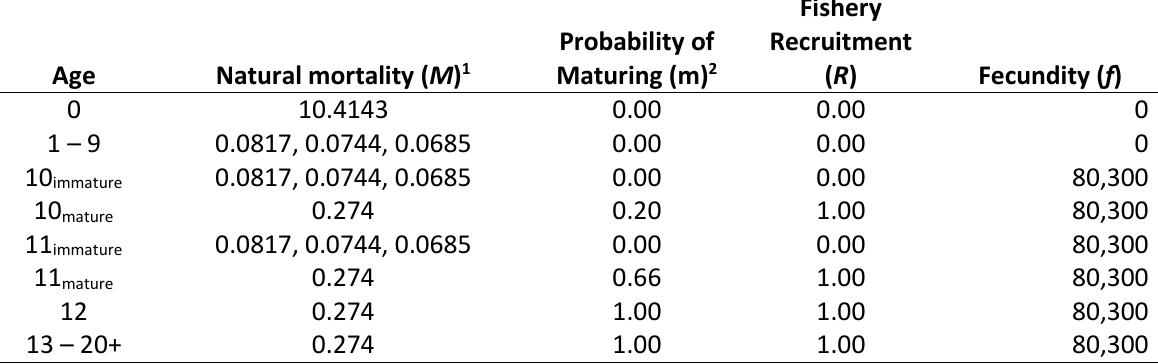
Table 48. Horseshoe crab life history parameters used in the projection model to estimate biological reference points.